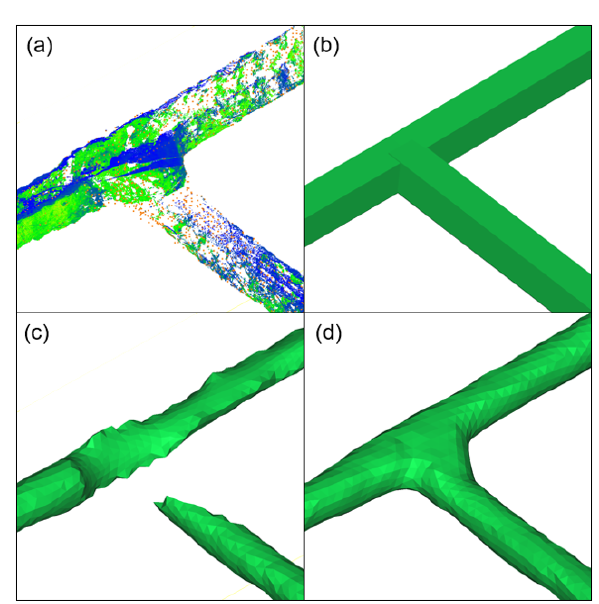
Figure 8. Comparison of point clouds and different models. (a) The collected TLS point clouds, the extracted and the completed featured points. Feature points are colored orange. (b) Design model; (c) reconstructed 3D model without feature point completion; (d) reconstructed 3D model after feature point